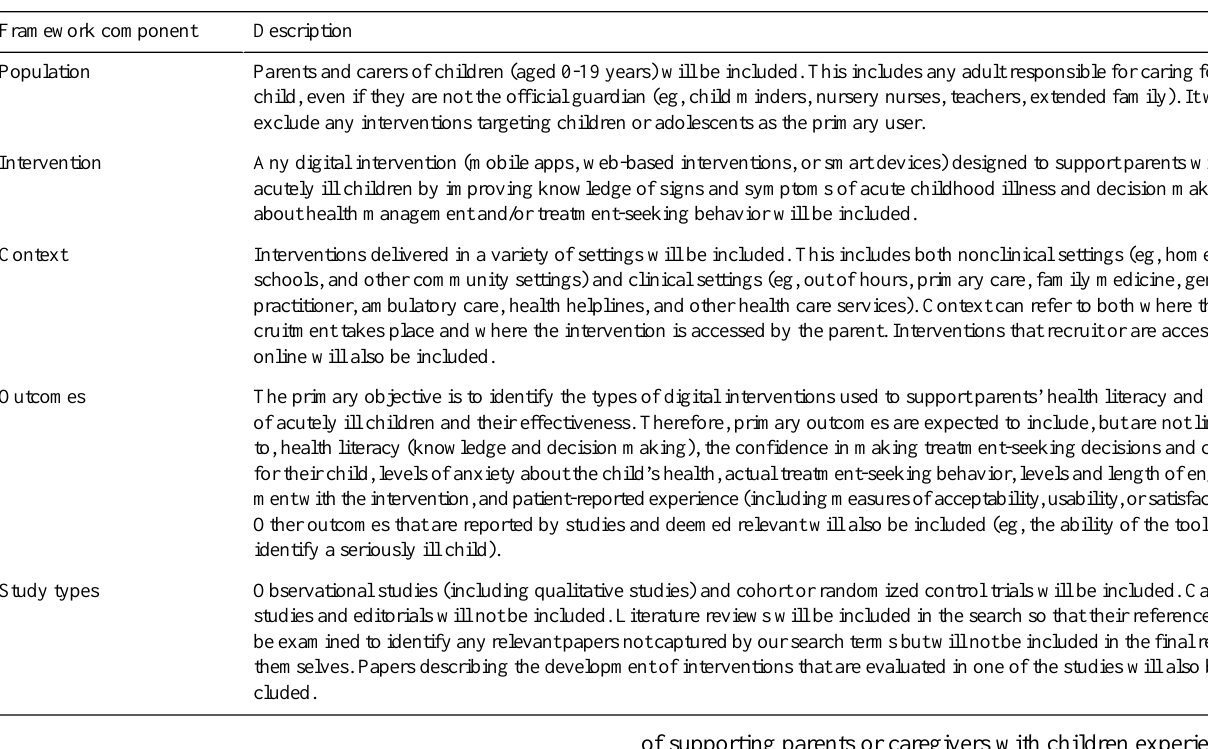
Table 1. Population, intervention, comparator, outcome, and study type (PICOS)